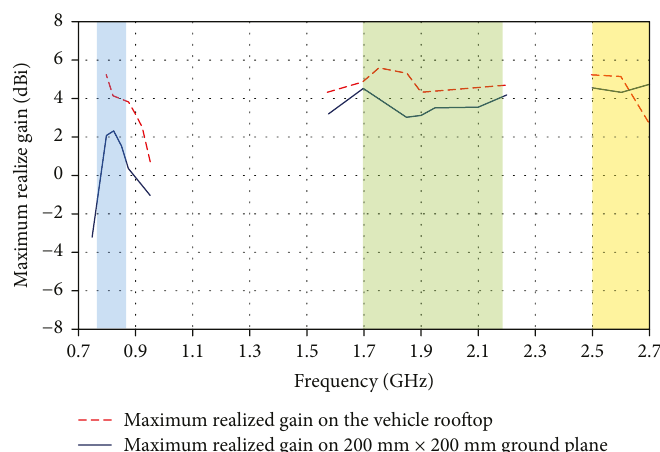
Figure 16: Comparison of maximum realized gains according to the